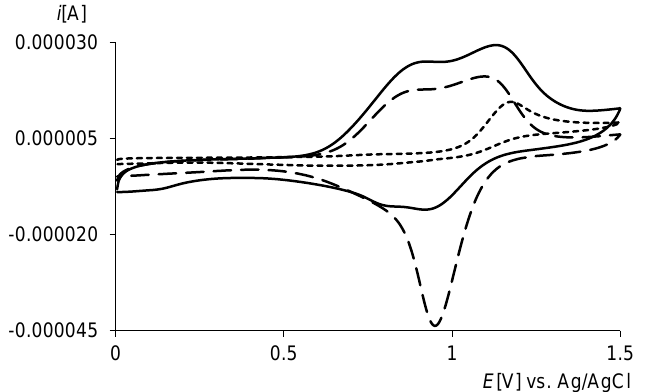
Figure 5. Cyclic voltammograms, 2nd scan, v = 0.05 V · s − 1 , vs. Ag/AgCl: Pt poly [Ni(salcn)] in TBAH (0.1 mol · dm − 3 )/CH 2 Cl 2 (after electropolymerization: 3 scans, v = 0.05 V · s − 1 )— dashed line, Pt poly [Ni(salcn)] in catechol(10 – 3 mol·dm − 3 )/TBAH/CH 2 Cl 2 — solid line; Pt in catechol/TBAH/CH 2 Cl 2 — dotted line.